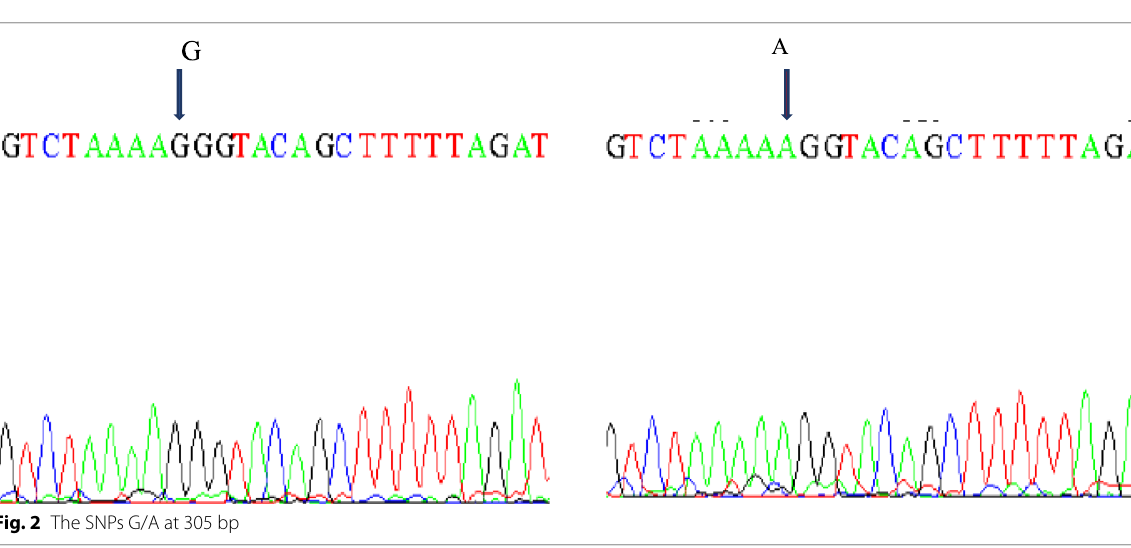
The two detected haplotypes were submitted to Gen- Bank/NCBI under accession numbers OM 278349 and OM 278350. Alignment of several sequences yielded a consensus length of 531 sites (Fig. 3), which included base pairs and gaps with four InDel sites and InDel hap- lotype diversity: 0.121. With a transition/transversion bias (R) of 8.99, transitional pairs were more common than transversional pairs on average. The alignment revealed 100% homology with the sequences obtained from GenBank of camels: Table 1 shows the pairwise genetic distances between the 16 camel populations estimated using the Kimura 2-parameter model. The genetic distances varied